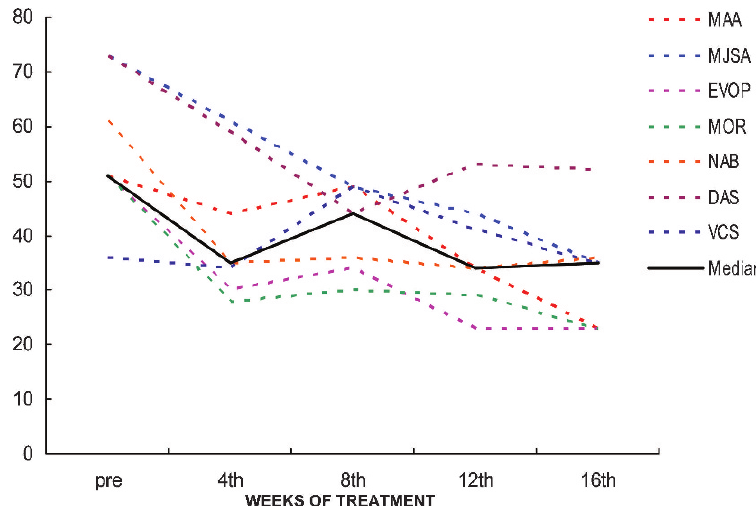
Figure 1 - Anxiety scores of volunteers as evaluated by STAI-S questionary during sessions with therapeutic massage.